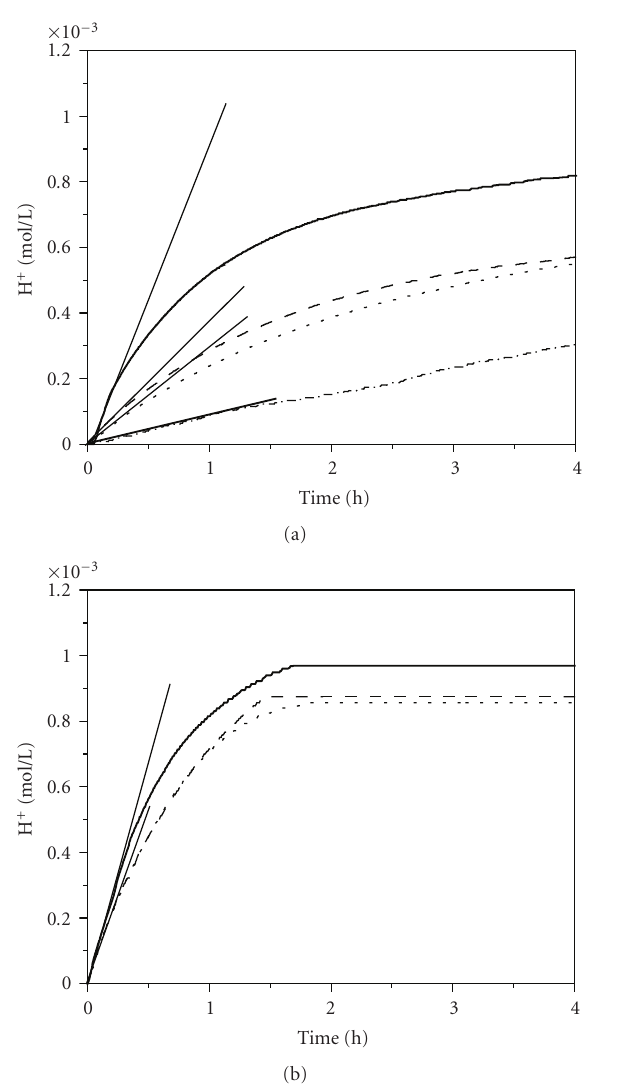
Figure 2: (a) Degradation of DCA (shown as release of H + ) using the photocatalyst Degussa P25 at pH 3 in 3 consecutive runs, 1st run (—), 2nd run (–––), 3rd run ( ··· ), a 3rd run (- · -) with addition of 4mM Cl − before the run started, and slope ( ) used for the determination of the photonic e ffi ciency of each run with I ≈ 3 . 39 × 10 − 2 Einstein L − 1 h − 1 . The photocatalyst loading was 0.5g/L. (b) Degradation of DCA (shown as release of H + ) using the photocatalyst Degussa P25at pH 3 in 3 consecutive runs with intermittent washing between the runs, 1st run (—), 2nd run (–––), 3rd run ( ··· ), and slope ( ) used for the determination of the photonic e ffi ciency of each run with I ≈ 3 . 39 × 10 − 2 Einstein L − 1 h − 1 . The photocatalyst loading was 0.5 g/L.